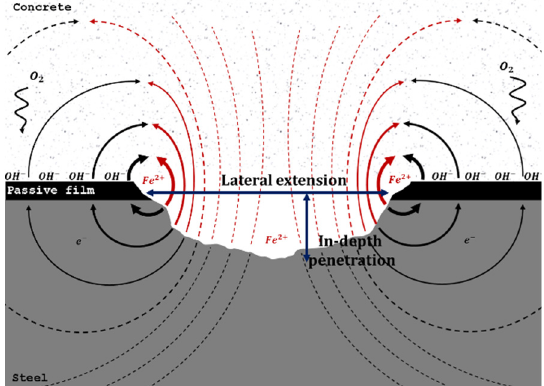
Figure 9. Localized corrosion mechanism : extension in length of anodic zone due to higher current density at the border between anodic and cathodic zones: adapted from